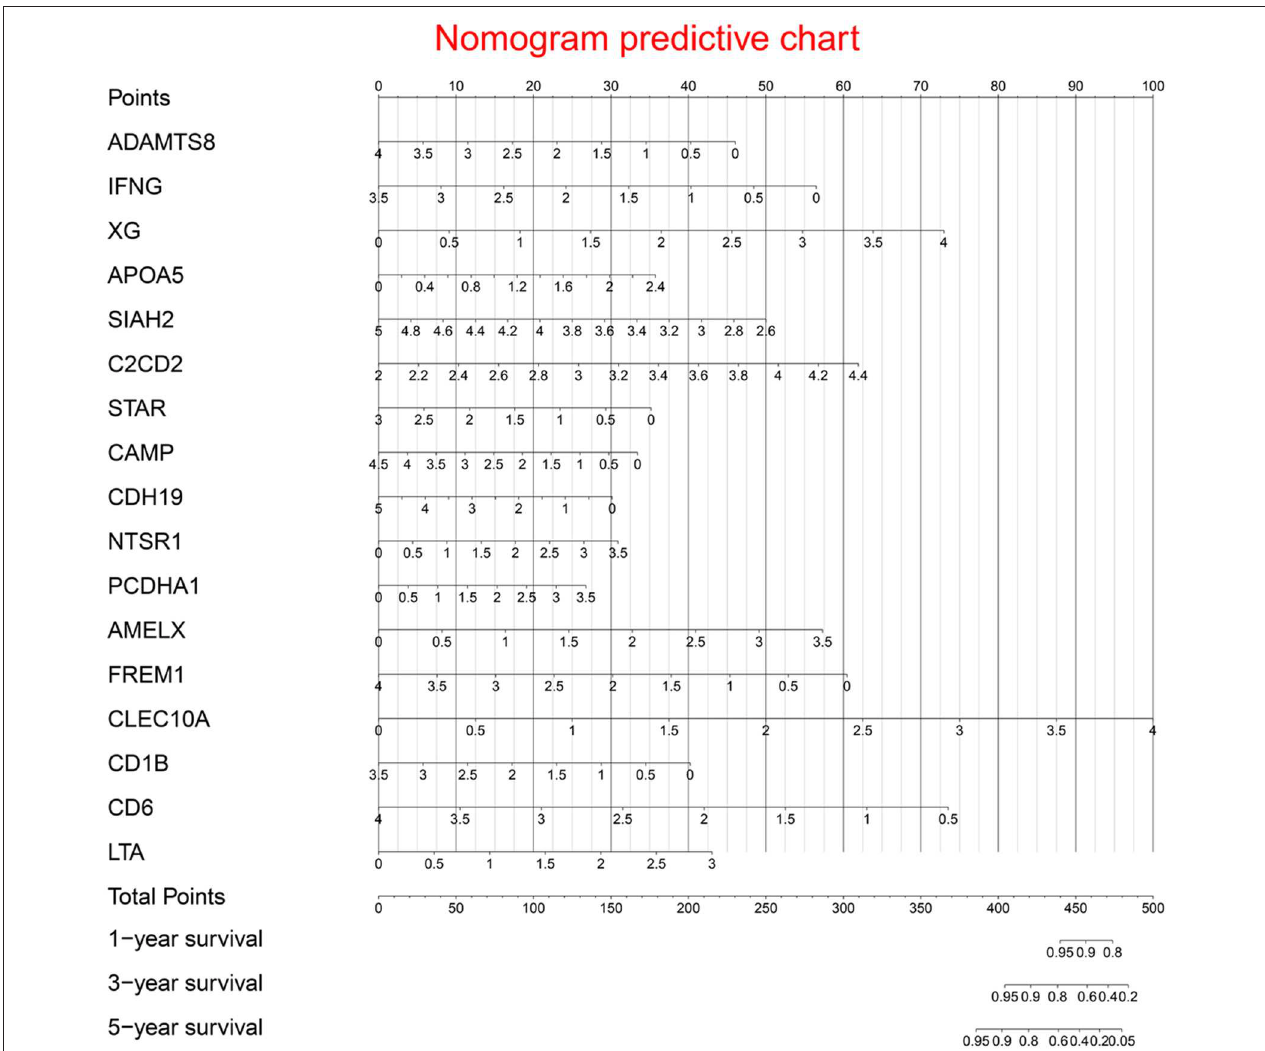
FIGURE 5 | Prognostic nomogram